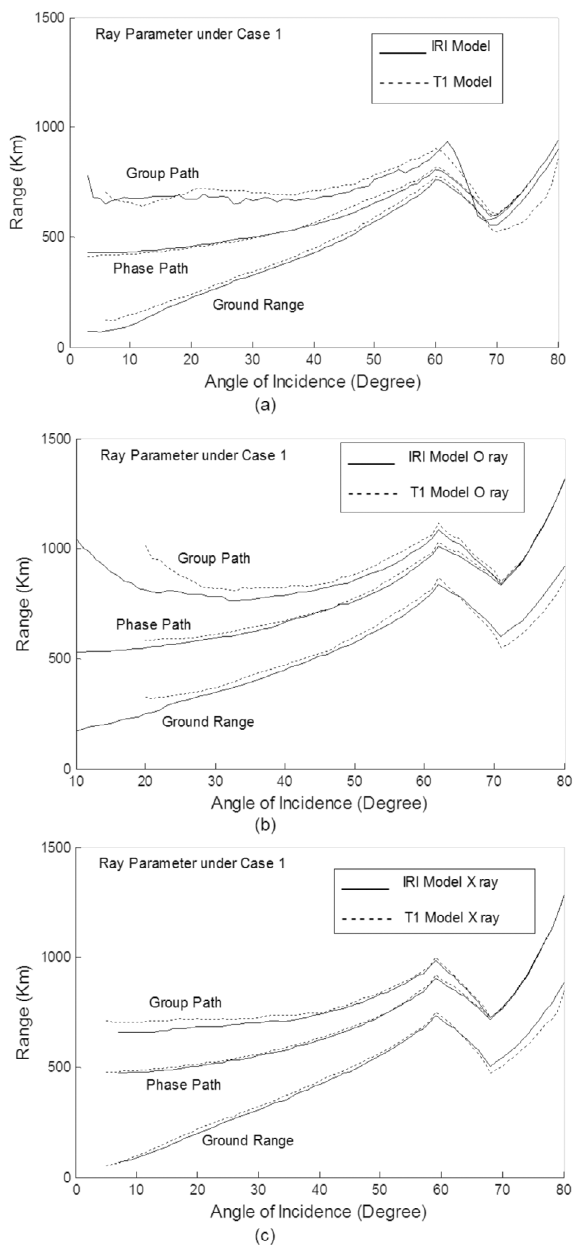
Figure 4. Ray tracing parameter variation with different angle of incidence under Case 1 at 7.5 MHz for: (a) ray tracing without in- fluence of Earth’s magnetic field (b) O mode propagation (c) X mode propagation.